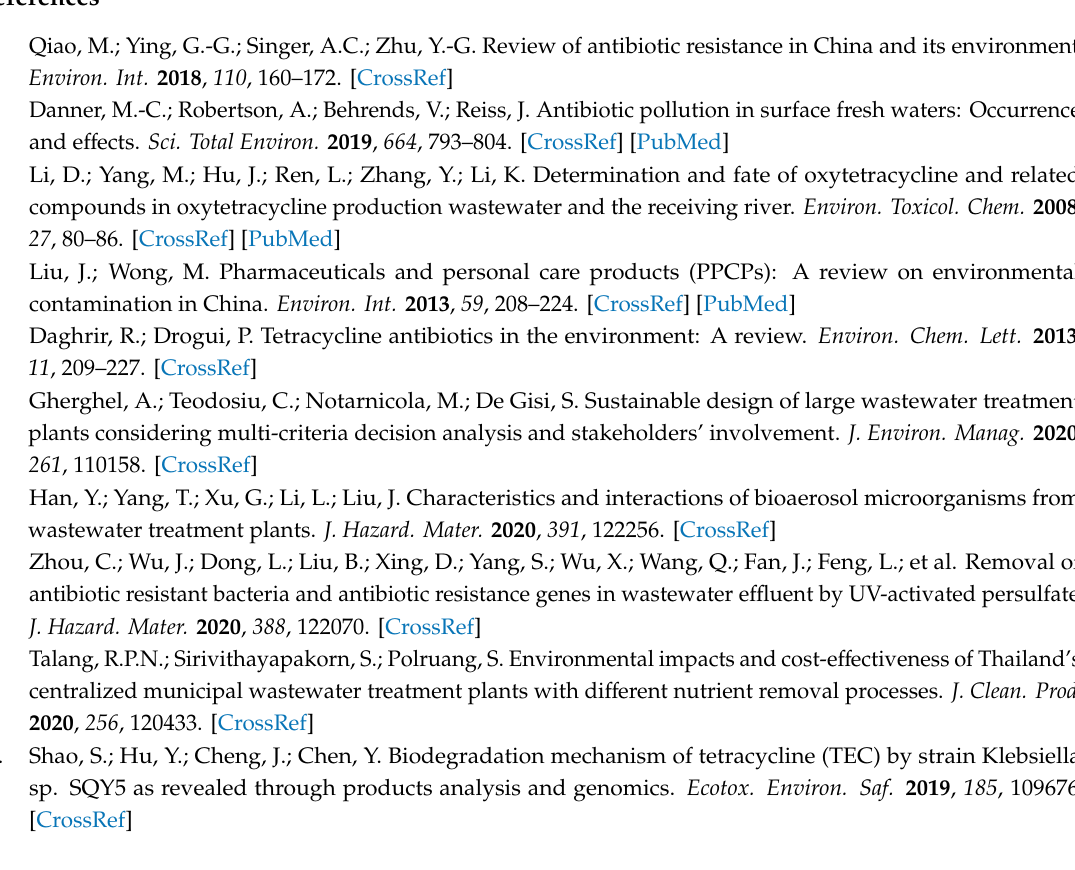
Supplementary Materials: The following are available online Table S1: The intermediate products of the tetracycline degradation, Figure S1: The structure of tetracycline, Figure S2: The BPC of intermediate products of the tetracycline